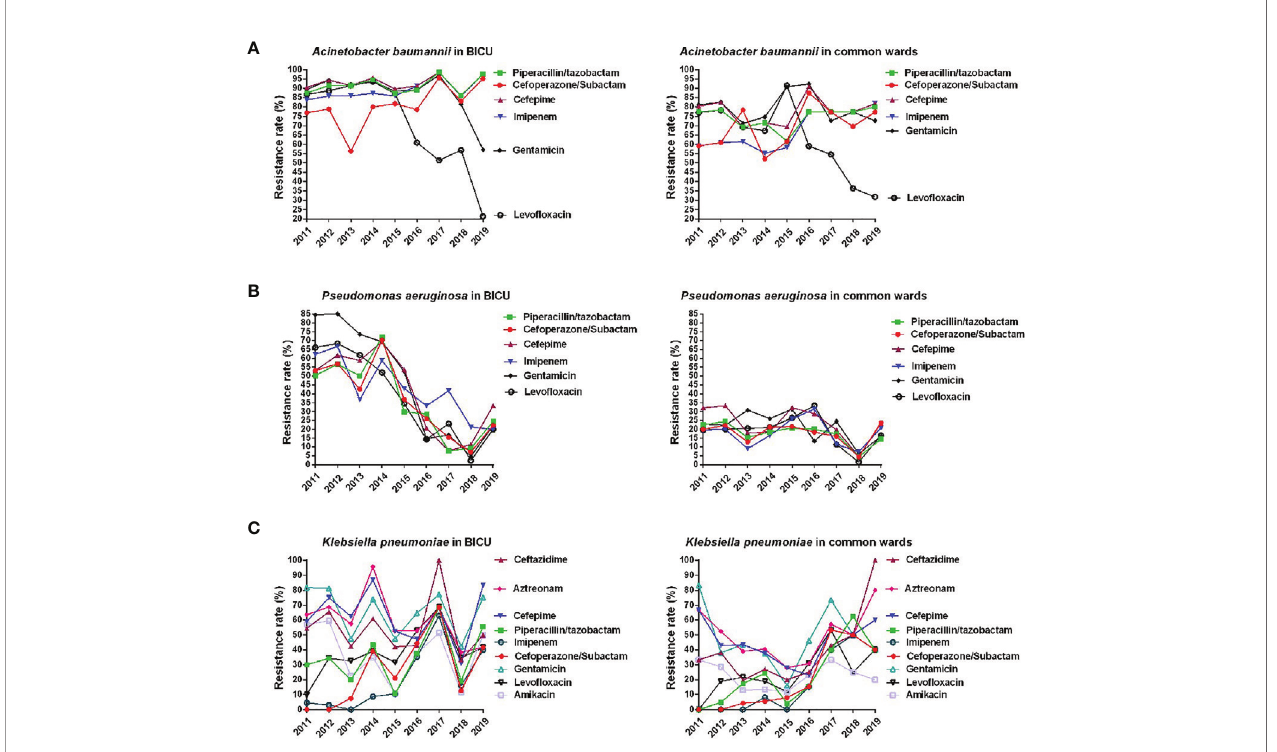
FIGURE 5 | Annual changes of antibacterial resistance of main Gram-negative bacteria. (A) Annual distribution of antibacterial resistance of Acinetobacter baumannii from burn ICU (left) and common ward (right). (B) Annual distribution of antibacterial resistance of Pseudomonas aeruginosa from burn ICU (left) and common ward (right). (C) Annual distribution of antibacterial resistance of Klebsiella pneumonia from burn ICU (left) and common ward